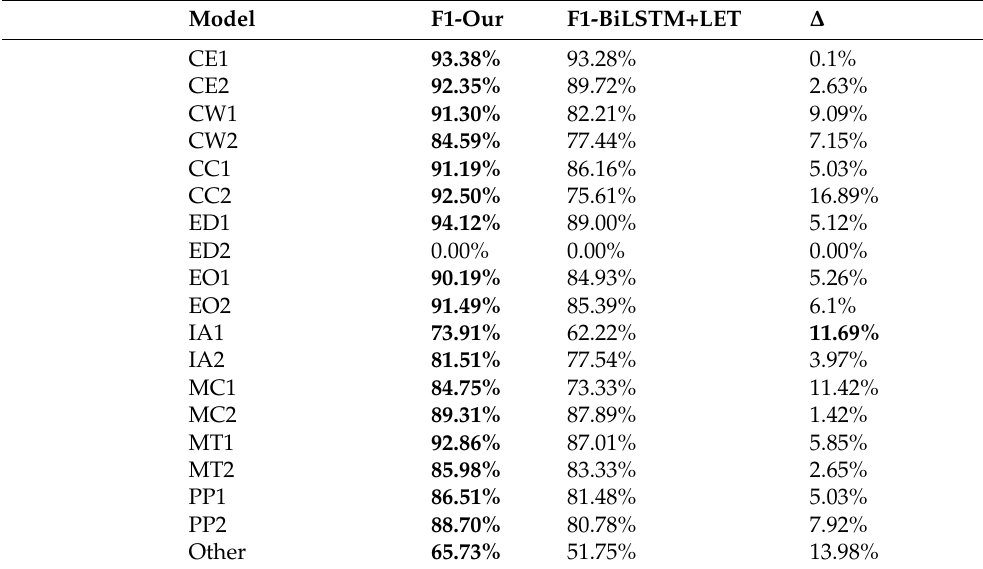
Table 8. F1 values for each category in the SemEval-2010 Task8 dataset for both models, taking directionality into